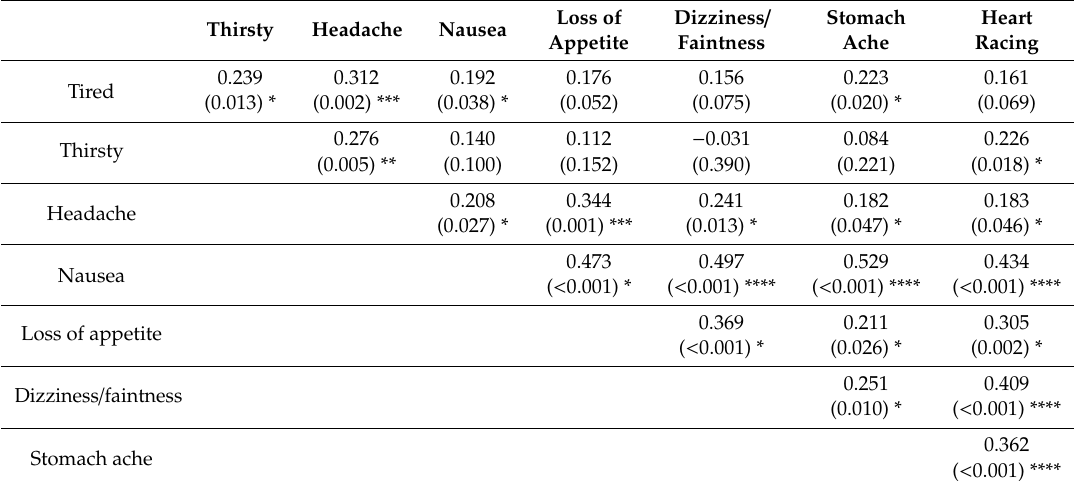
Table 2. Correlations (and significance) of items included in factor analysis of AHS.